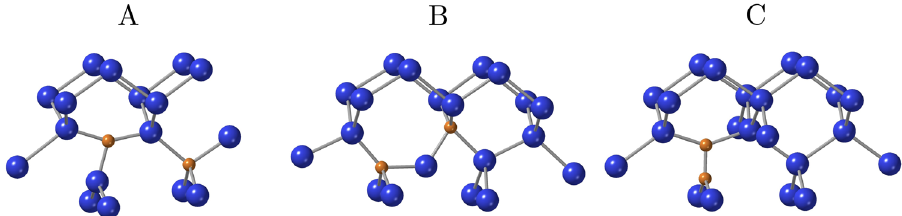
Fig. 1 | Three con fi gurations of carbon pair defects in silicon. A , B , and C label the three con fi gurations identi fi ed in prior studies. Brown and blues spheres are the carbon and silicon atoms, respectively. The fi gures are made by Crystal Maker TM .